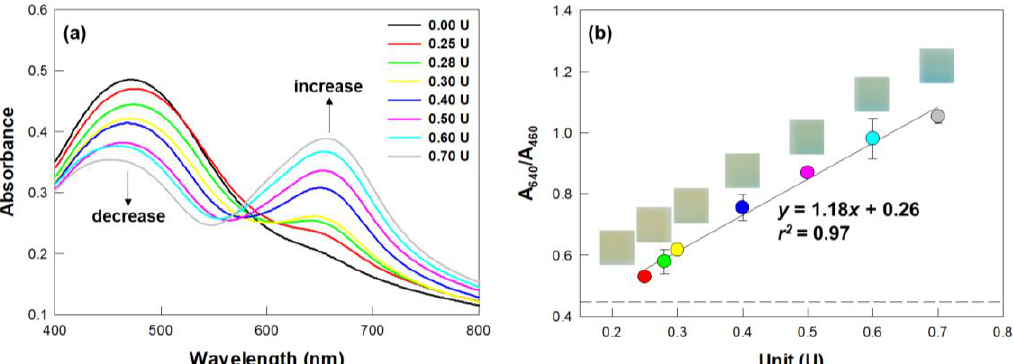
Figure 2. Detection of urease enzyme using the colorimetric film sensor. ( a ) Absorbance spectra and ( b ) A 640 /A 460 values of sensors exposed to various units of urease. The dashed line depicts the A 640 /A 460 value of the sensor not exposed to urease (0.00 U, negative control). Symbols and error bars indicate the mean and standard deviations of biological triplicates. Insets show photographs of the sensors exposed to the various units of urease.